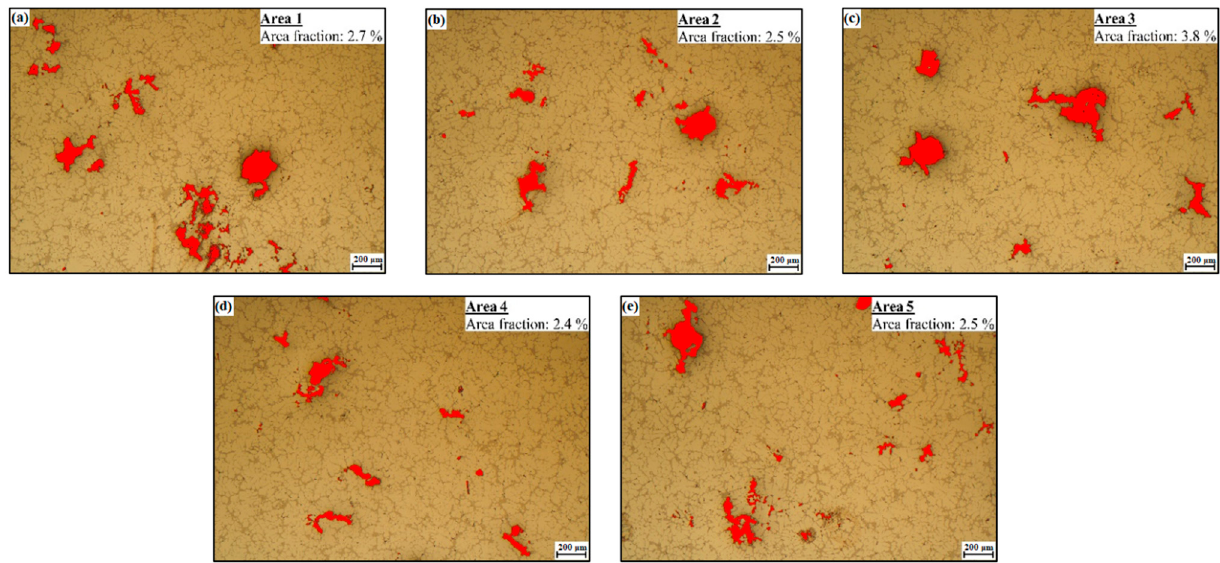
Figure 6. ( a – e ) Example of porosity evaluation by using Quick Photo Industrial 3.1 software (alloy with 0.20 wt. % Zr addition, H 2 SO 4 etch.) .